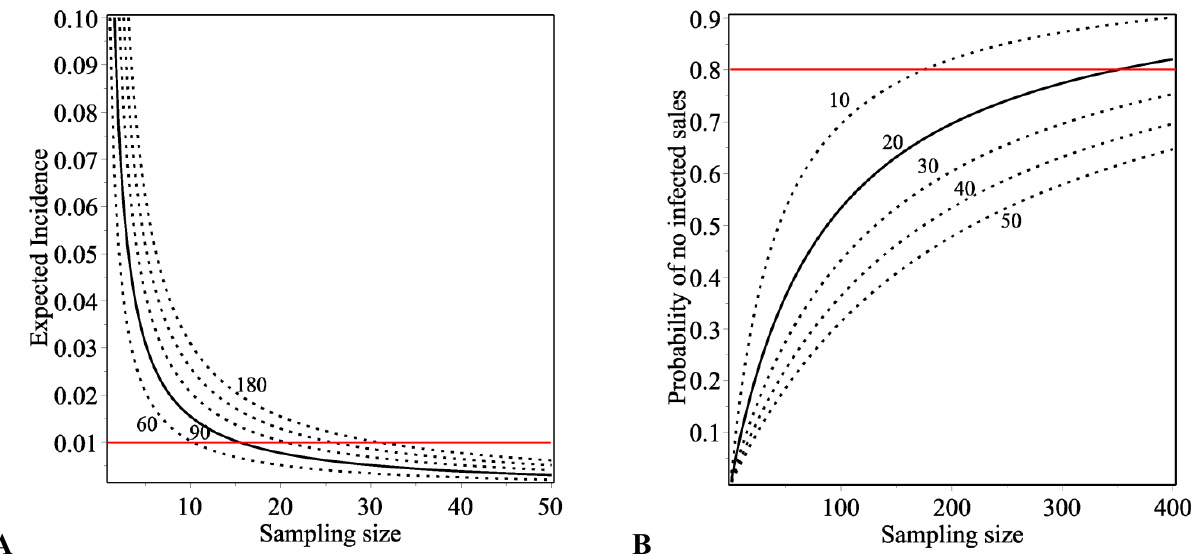
A B Figure 2. ( A ) The expected incidence for a number of sampling intervals (60, 90, 120, 150, and 180 days) depends on the sampling size for ash dieback. The solid line shows a typical sampling interval time between inspections (90 days). In order to detect the disease at incidences below 0.01 there are a number of sampling strategies which can be adopted. If the sampling size is over approximately 35 individuals, the detection incidence stays below 0.01. ( B ) The probability that no infected individuals were sold before disease detection, depends on the sampling size. For this example we take a sampling interval of Δt = 90 days and a selling interval of Δτ = 30 days. Solid and dotted lines show number of plants sold (10, 20, 30, 40, 50) dependent on the sampling size. To ascertain that the probability that no infected sales taking place before detection stays above 0.8, the sampling size has to be much larger than the selling size. The solid line shows that if the nursery sells 20 trees per month, a monitoring strategy that samples ~350 plants every three months is needed to maintain this